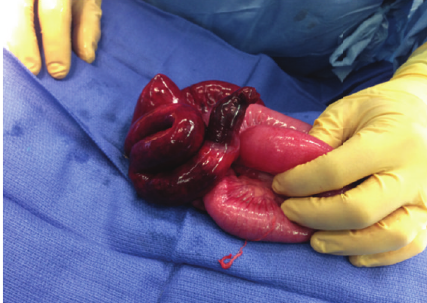
Figure 2: Intraoperative photograph showing portion of ischemic bowel.